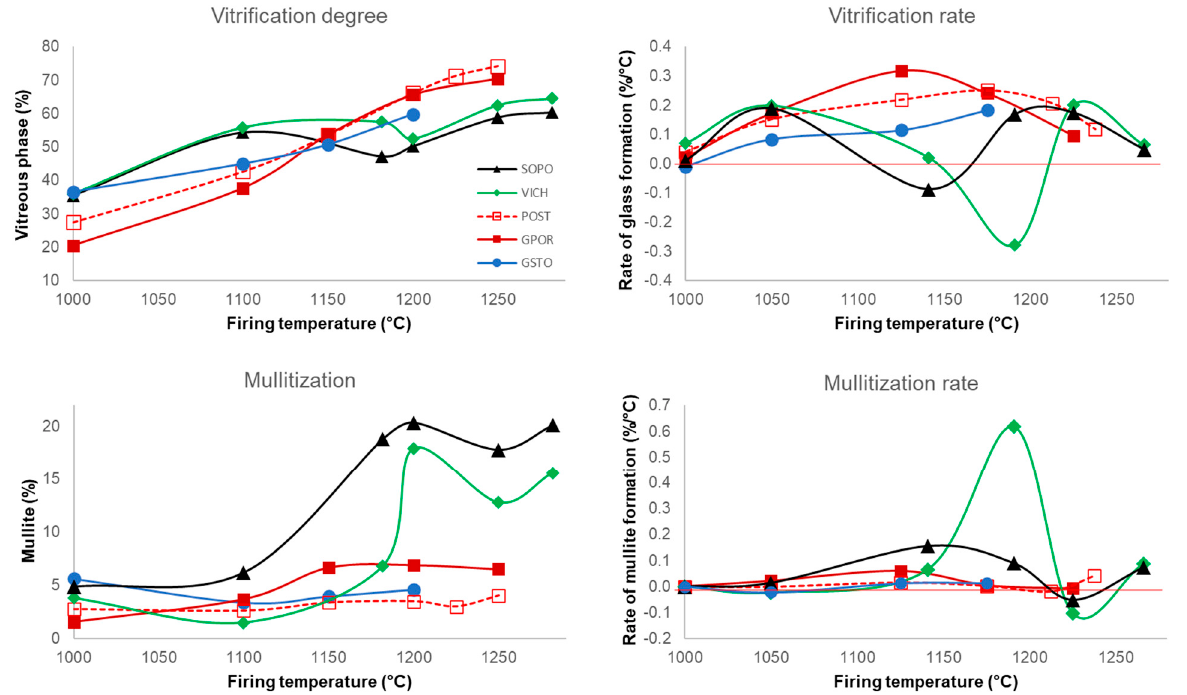
Figure 5. Amount of vitreous phase and vitrification rates (above); amount of mullite and mulliti- zation rate (below) vs. firing temperature.